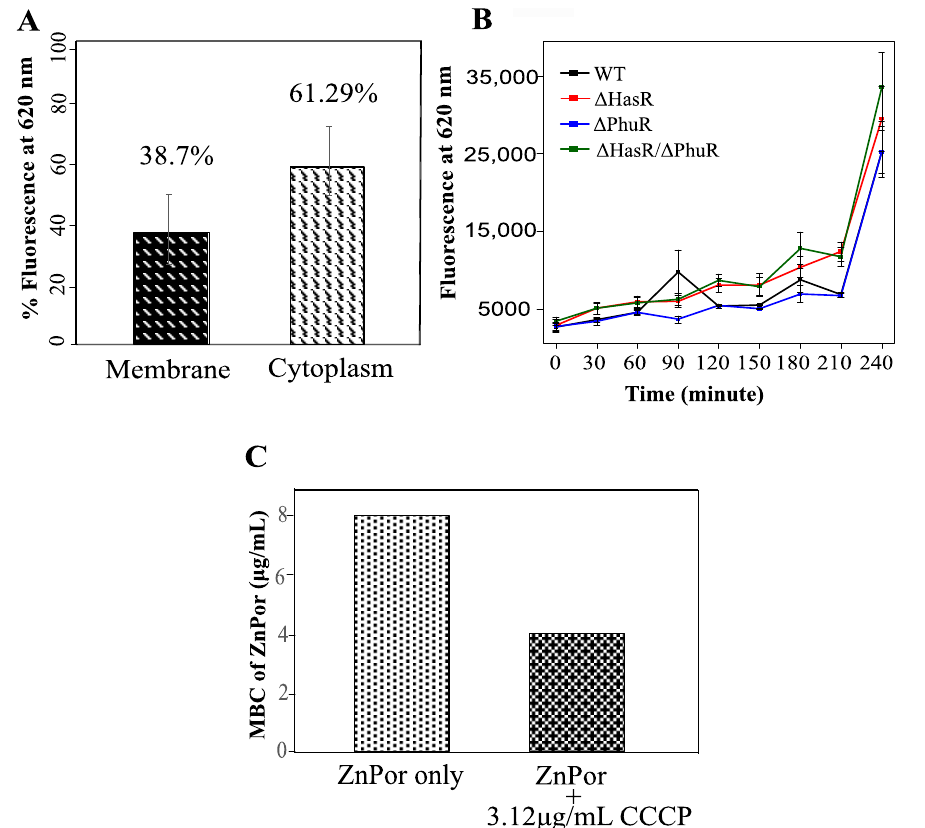
Figure 3. Uptake and distribution of ZnPor in PsA. ( A ) Levels of ZnPor in PsA cytoplasm of wild-type cells. Overnight PsA cultures were diluted to 0.15 optical density (OD) with MSG and exposed to 32 µ g / mL ZnPor for 2 h. Cell suspensions were then sonicated (20 min) and centrifuged at 20,000 ×